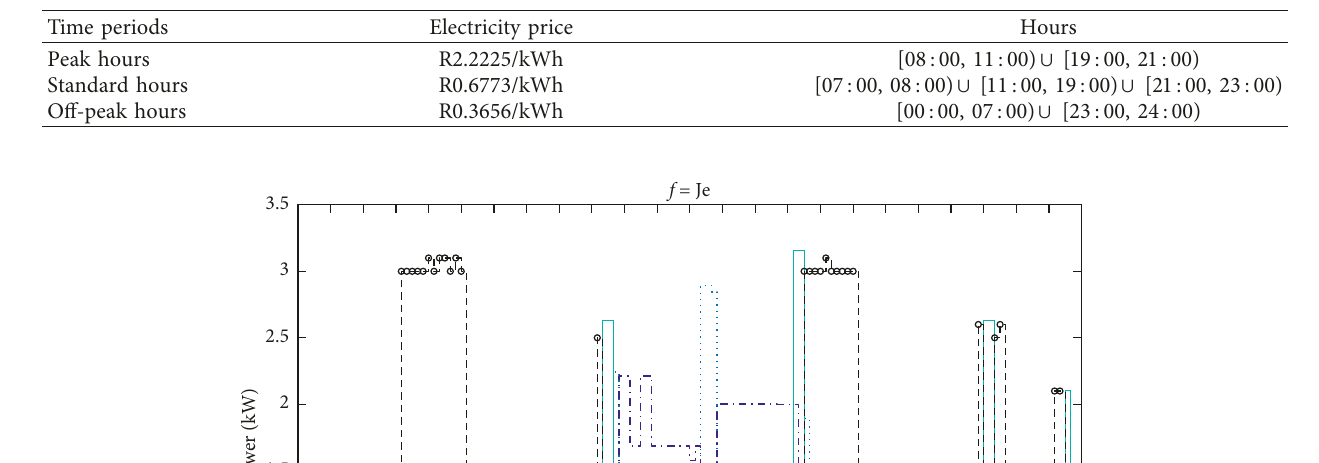
Table 4: TOU tariff.